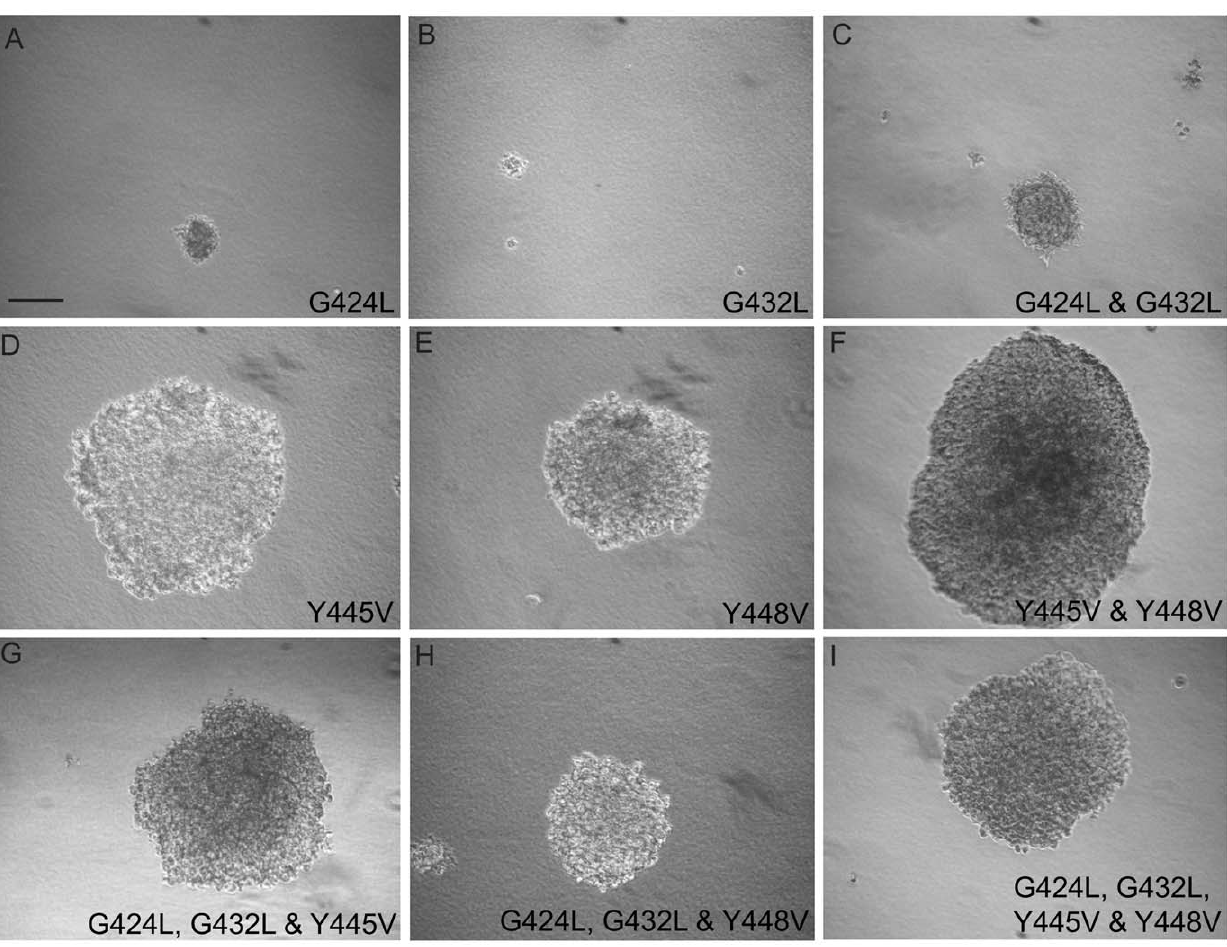
Figure 5. Anchorage Independent Growth in Soft Agar. ( A–I ) show the appearance of colonies formed by the various CEACAM1-4S sublines after 3 weeks in soft agar: ( A ) G424L; ( B ) G432L; ( C ) G424L and G432L; ( D ) Y445V; ( E ) Y448V; ( F ) Y445V and Y448V; ( G ) G424L, G432L and Y445V; ( H ) G424L, G432L and Y448V; ( I ) G424L, G432L, Y445V and Y448V.